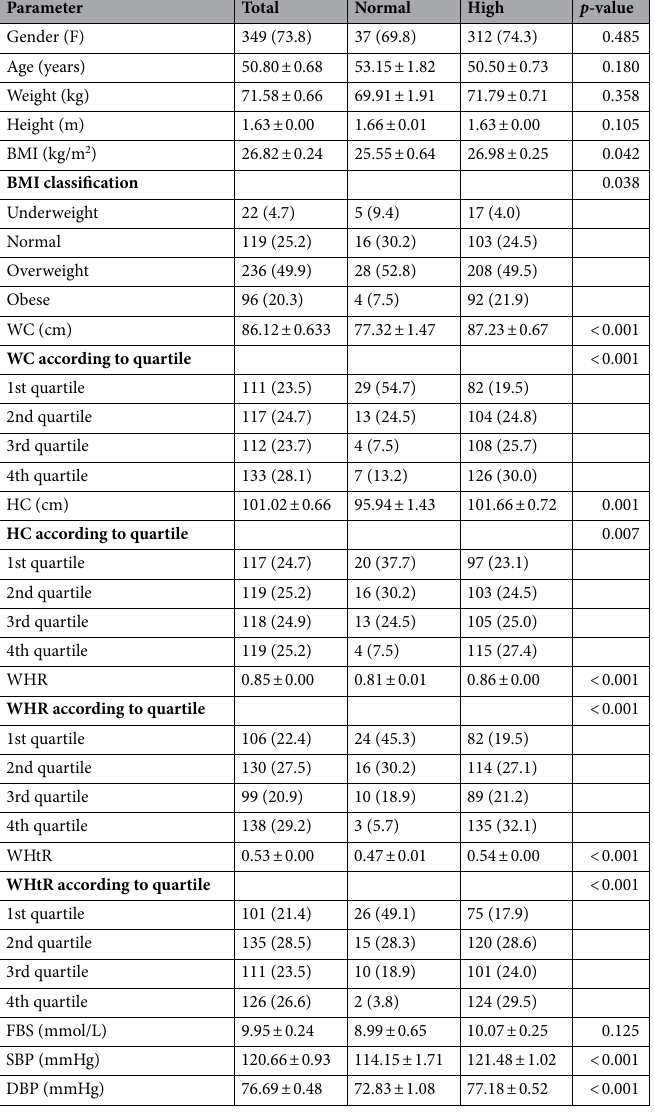
Table 1. Baseline characteristics of diabetic patients stratified by visceral fat levels. Data are presented as frequencies with percentages in parentheses and means ± standard errors of the means. Where appropriate, categorical data were compared using Fisher’s exact test or the Chi-squared test, and continuous data were compared using Student’s